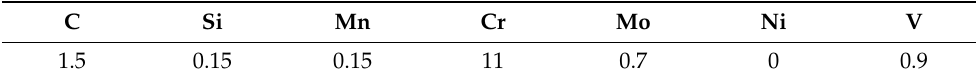
Table 2. Chemical composition of NC11LV steel (%).